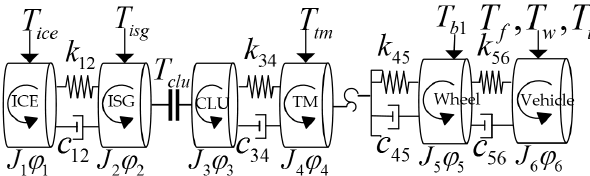
Figure 6. Schematic diagram of the structure and force of hybrid electric vehicles (HEV) powertrain.